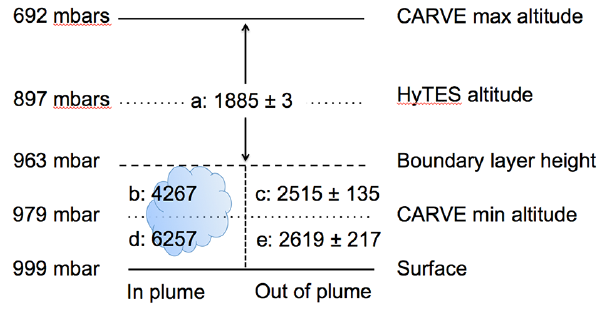
Figure 6. Partial column average (in ppb) to profile CH 4 in the plume and background region with CARVE and vehicle data.